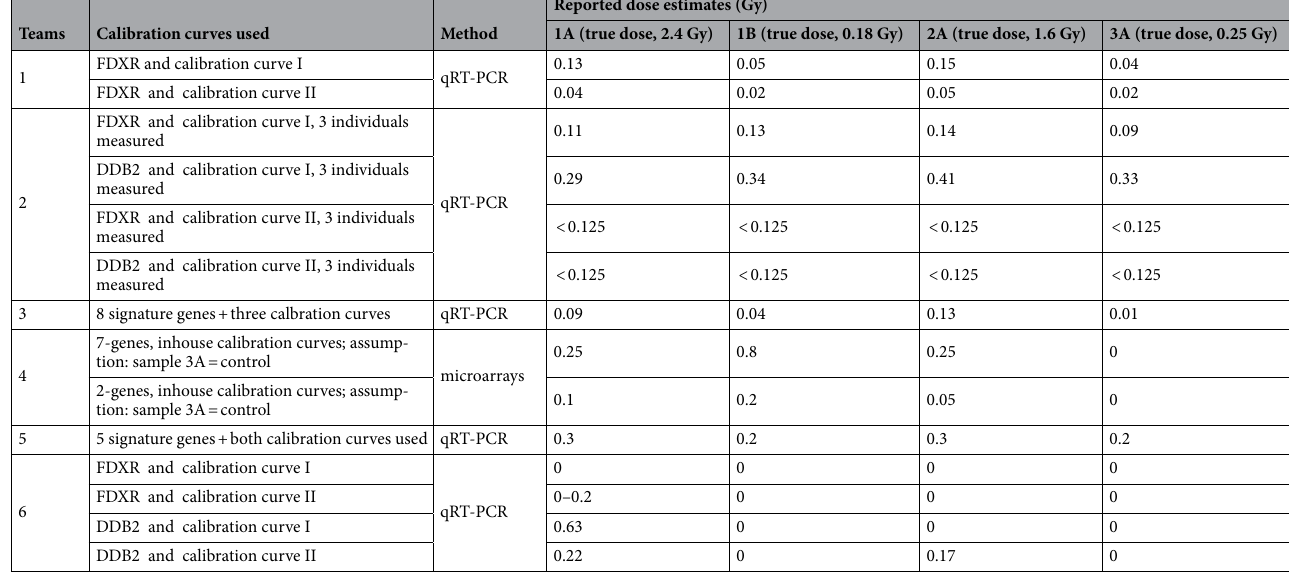
Table 3. The reported dose estimates from teams running qRT-PCR or microarrays are shown for each blinded sample irradiated with a known (true) dose, which is shown in parenthesis in the subtitles. Use of different calibration curves and genes generates several dose estimates per